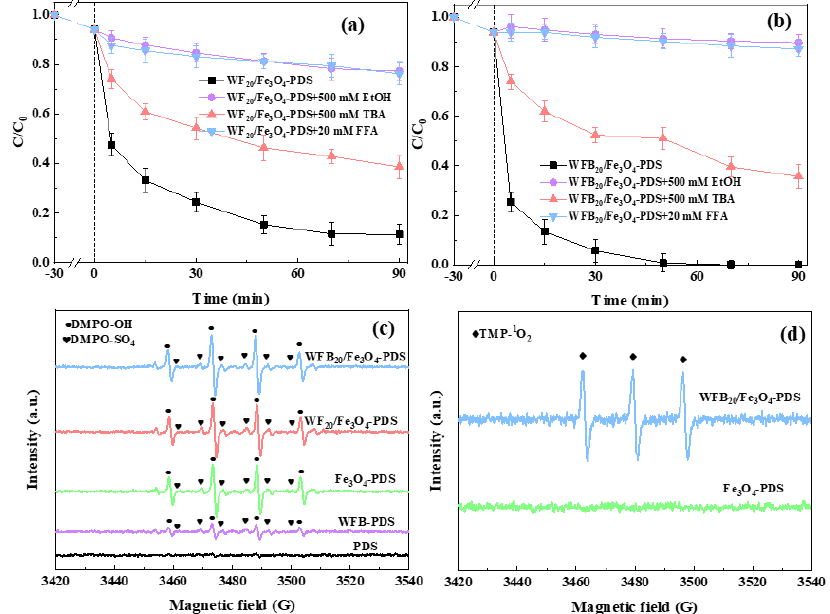
Figure 6. Effects of different radical scavengers on BPA degradation in ( a ) WF 20 /Fe 3 O 4 -PDS and ( b ) WFB 20 /Fe 3 O 4 -PDS systems; ( c ) DMPO-OH and DMPO-SO 4 spectra in different processes; ( d ) TMP- 1 O 2 spectra in different processes (conditions: catalyst 1.0 g/L, [PDS] 0 = 5.0 mM, [BPA] 0 = 0.02 mM, pH 0 = 3.00 ± 0.1).